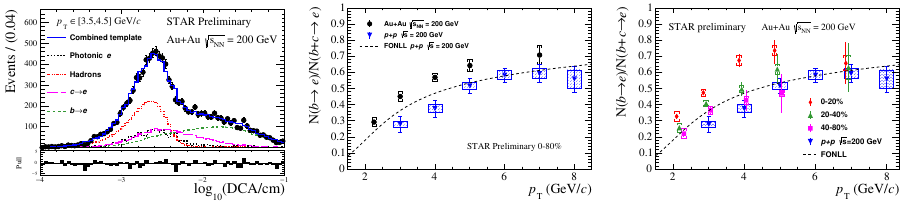
e , Figure 1. Left: log(DCA / cm) distribution for inclusive electrons with a template fit including b → = 200 GeV. Middle: the c e , and various background sources in 0-80% Au + Au collisions at √ s NN → e as a function of p T in 0-80% Au + Au collisions, along with that in p + p collisions and fraction of b → e as a function of p T in di ff erent centralities of Au + Au the FONLL prediction. Right: the fraction of b → collisions, along with that in p + p collisions and the FONLL